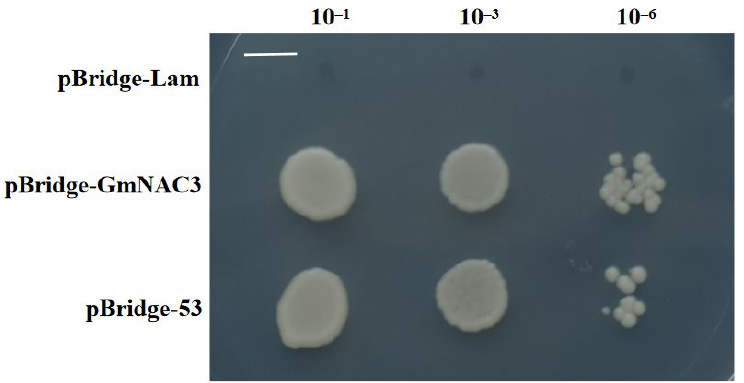
Figure 5. Transcriptional activation activity of GmNAC3 based on Saccharomyces cerevisiae strain Y2HGold at three different concentrations (10 –1 , 10 –3 , and 10 –6 ). pBridge–Lam vector: negative control not grown on the SD-Trp-His selective medium; pBridge–53: positive control; pBridge–GmNAC3: experimental group. Bar = 1 cm.